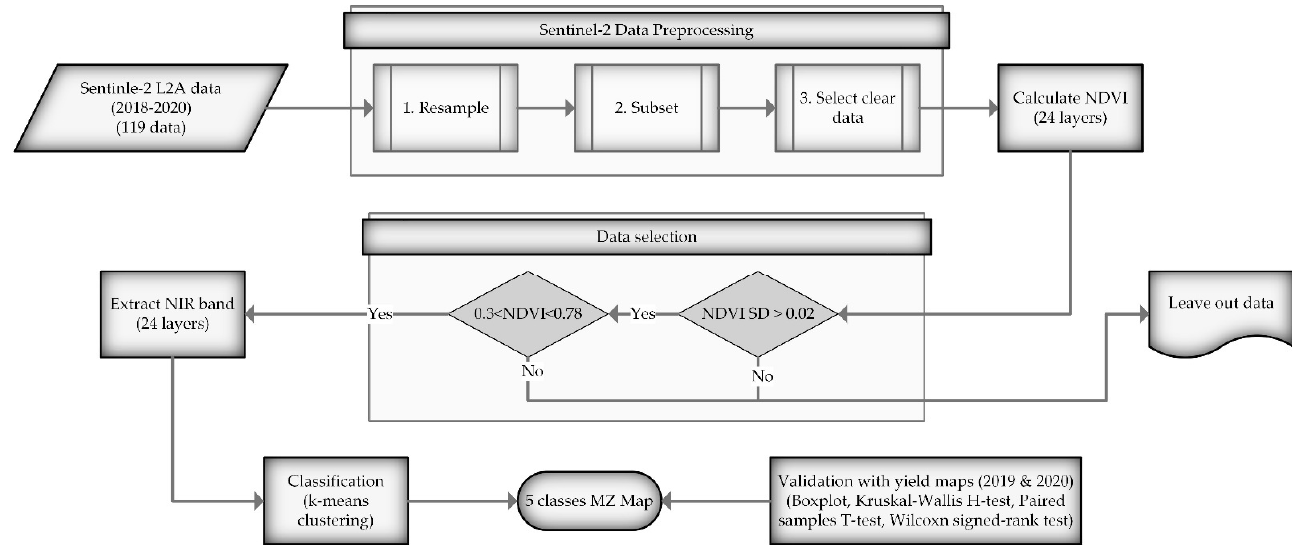
Figure 4. The workflow of model-3 (RS-based, unsupervised clustering). The K-means algorithm was performed with 5 classes and 100 iterations in SNAP V7 [72]. Moreover, mapping was conducted in QGIS V3.10 [75].